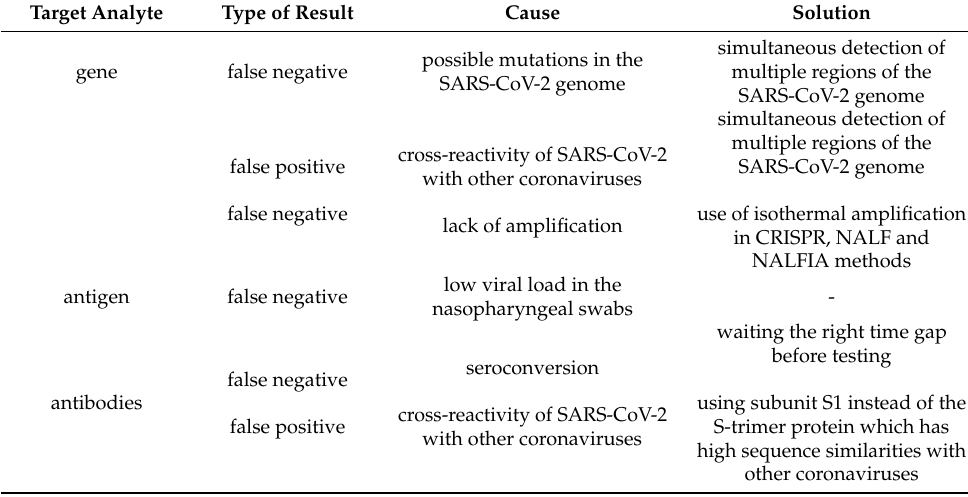
Table 4. Potential causes of false positive and false negative results with PBBs for COVID-19 detection, and the recommended measures to minimize